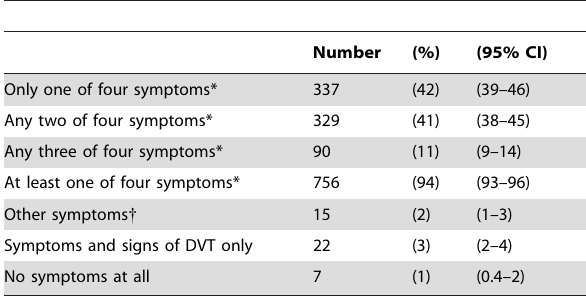
Table 5. Combination of clinical symptoms and signs in 800 patients with pulmonary embolism.